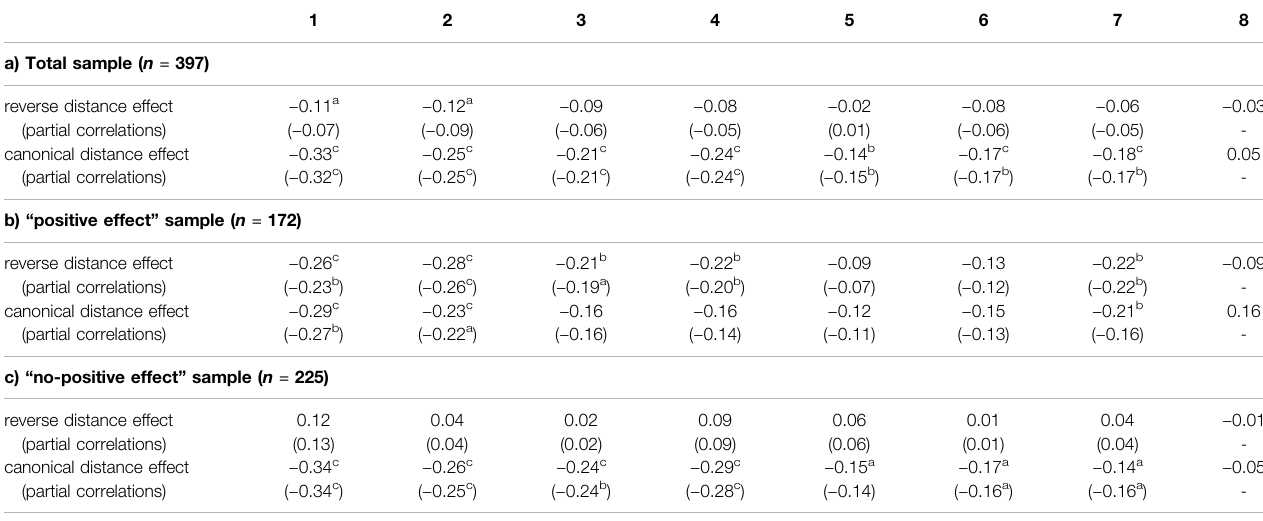
TABLE 4 | Bivariate and partial correlations among the distance effects and measures of mathematical competence across (A) the entire sample, (B) the “ positive effect ” sample and (C) the “ no-effect ”